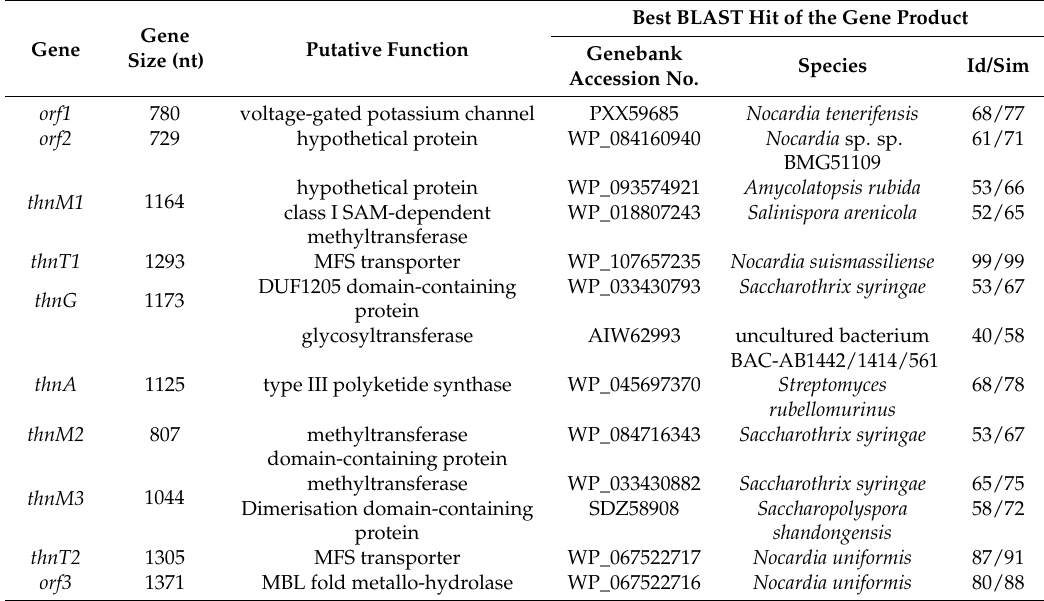
Table 3. Putative genes involved in the biosynthetic gene cluster of compound IBR-3 a .